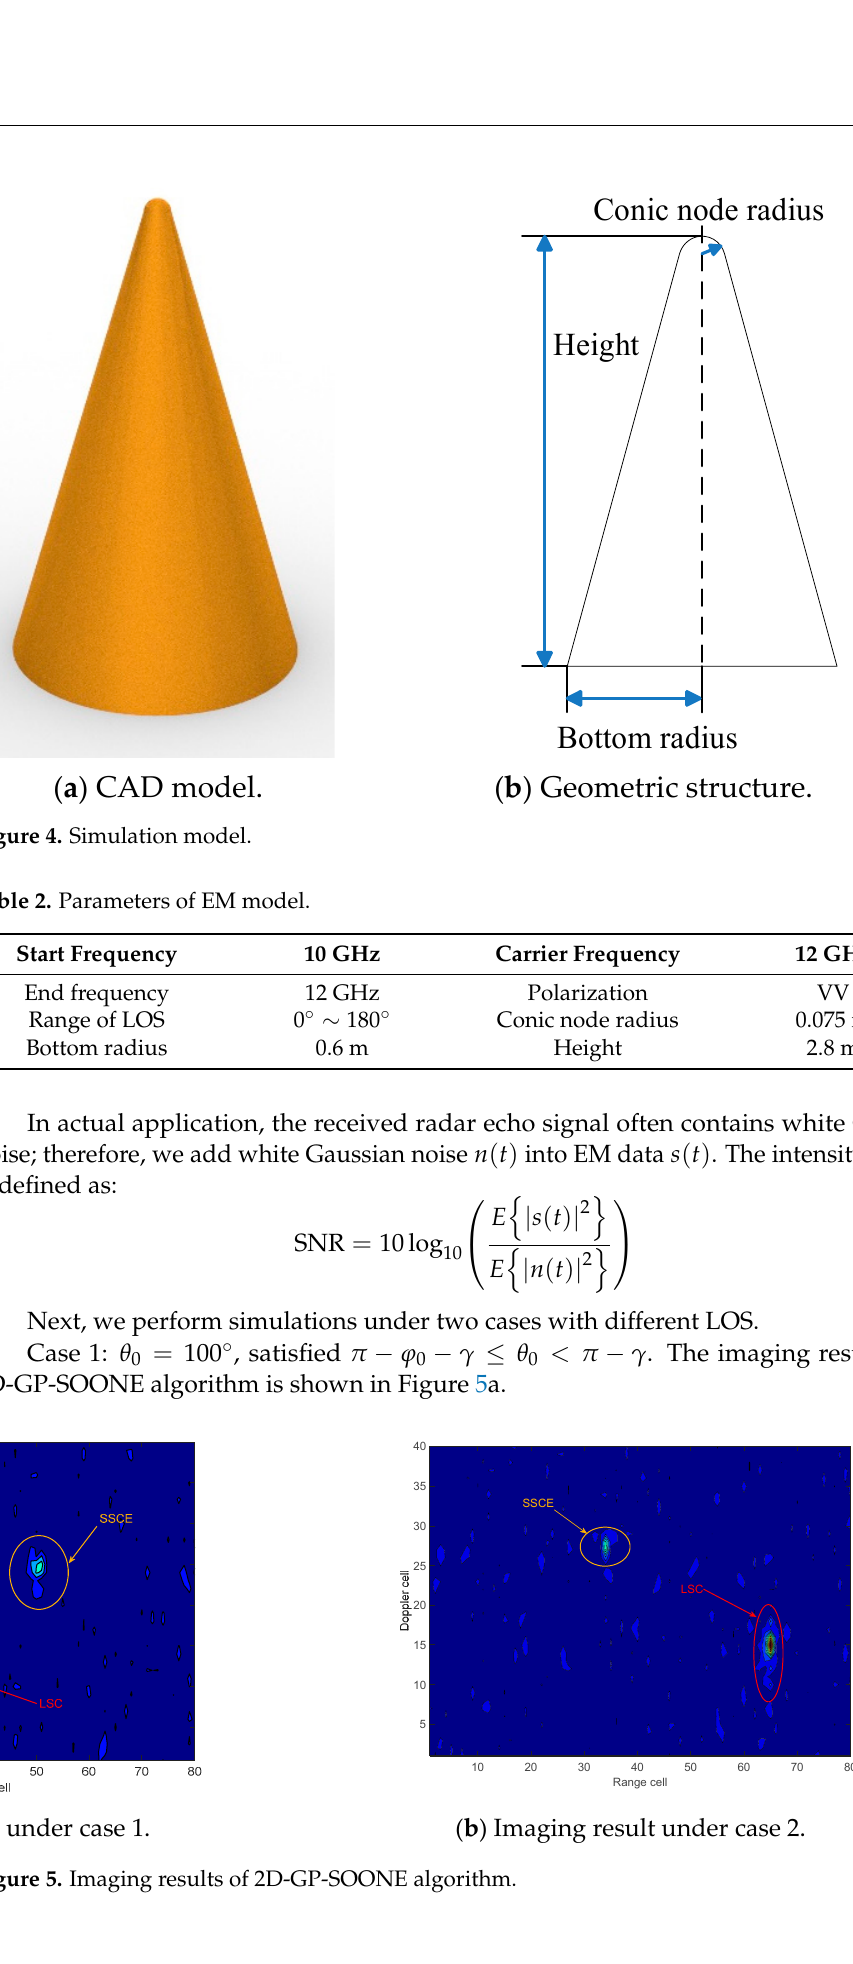
Figure 5. Imaging results of 2D-GP-SOONE algorithm.